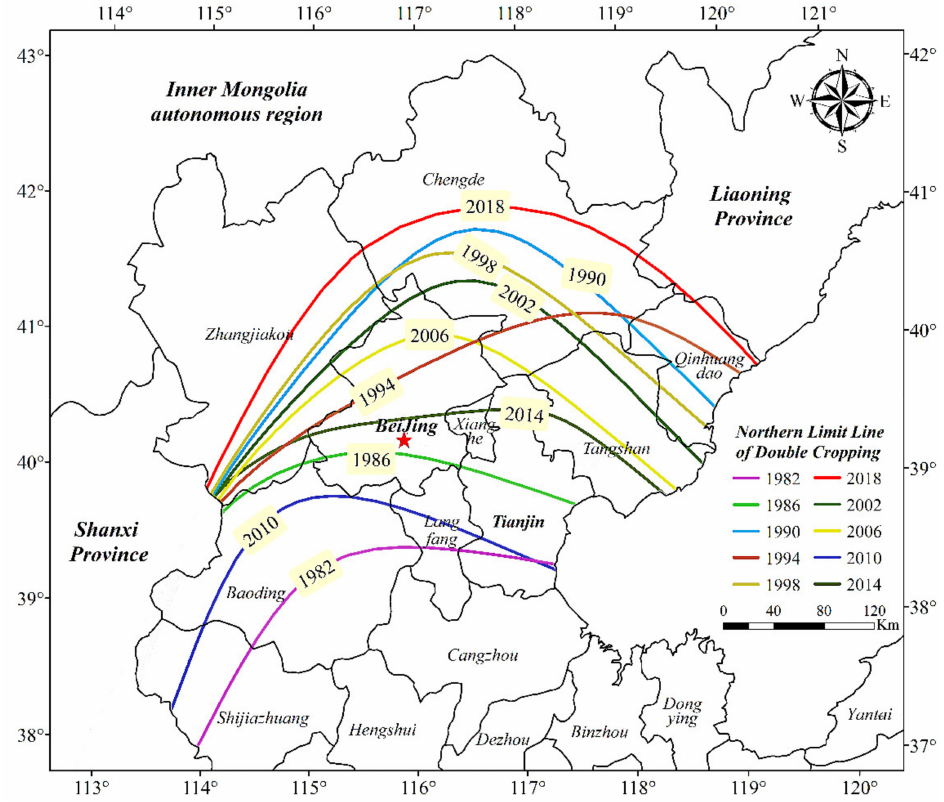
Figure 15. Location of the northern limit of the double cropping system on the NCP from 1982 to